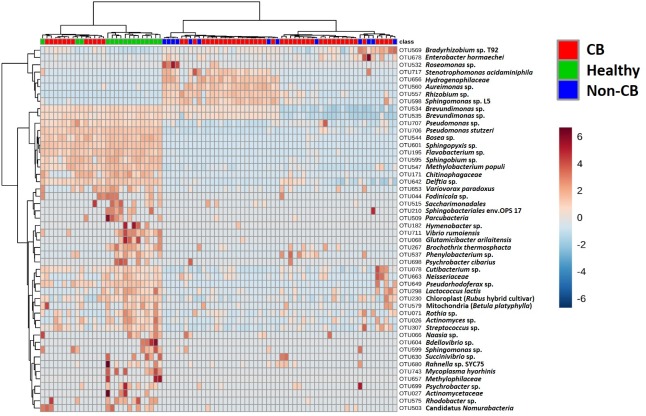
Heatmap showing samples (in columns) and the 50 most variable OTUs between groups (in rows), both clustered using an unweighted pair group method with arithmetic mean (UPGMA) approach.Legend at upper right denotes groups. Color scale (bar at far right) denotes normalized abundance of OTU in a given sample, relative to the abundance in other samples. Best annotation of each OTU is shown at right.